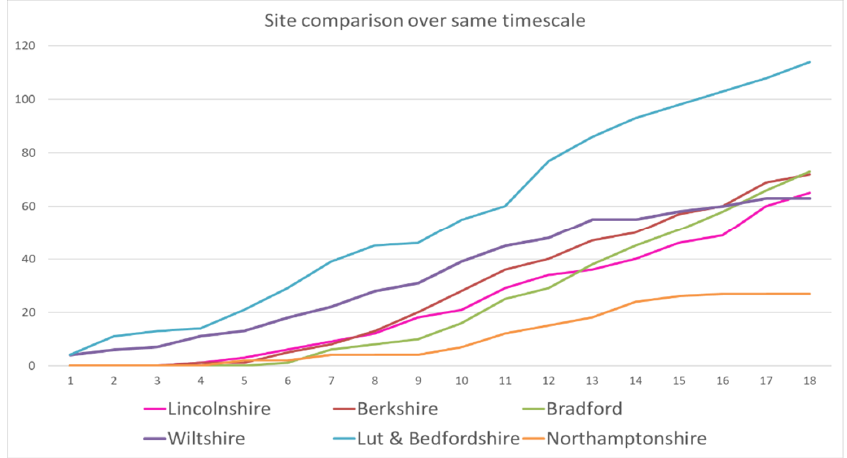
Figure 3. Jobs achieved: Comparison of sites over 18-month period.